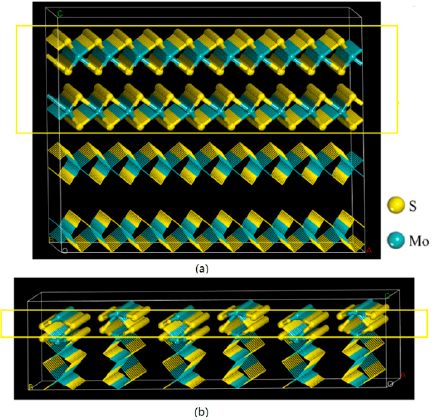
Figure 1. The optimization of MS001/MS100. ( a ) MS001; ( b ) MS100.